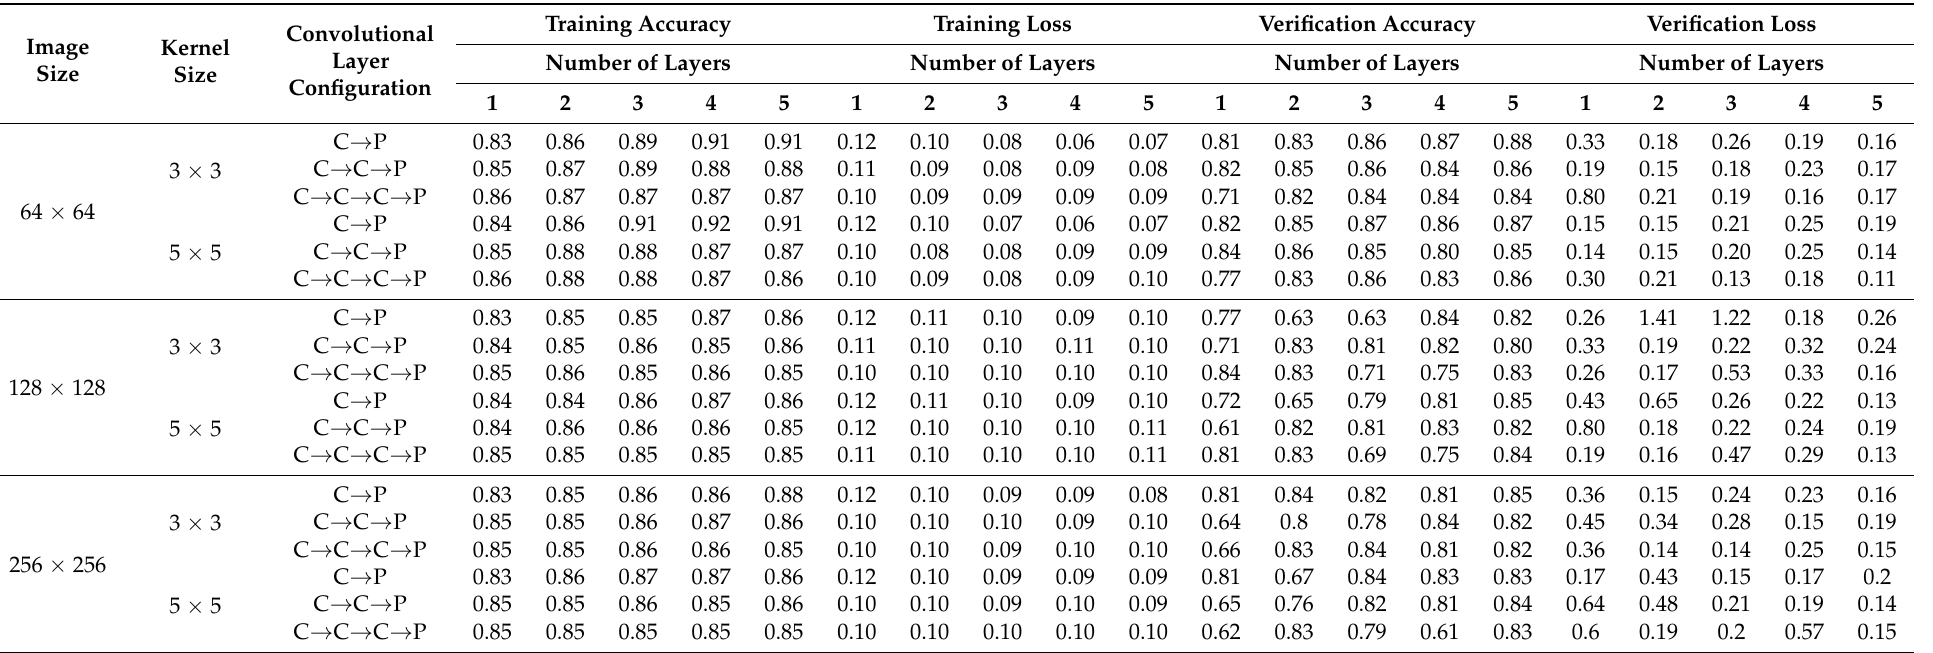
Table 3. Distribution of accuracy and loss values for the training and validation data of the deep learning